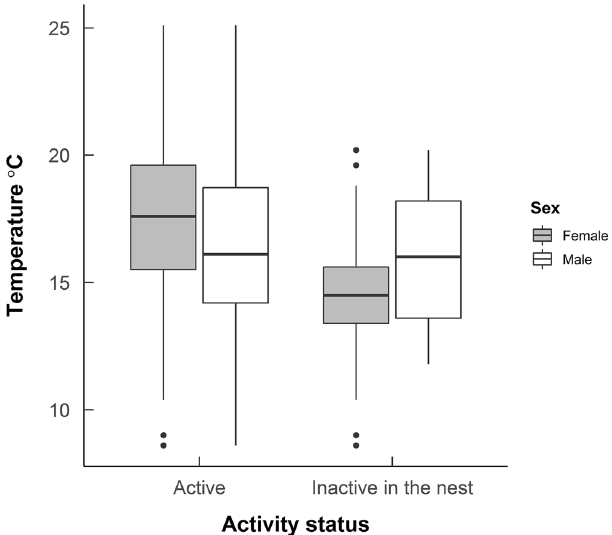
Figure 2. The mean nightly temperature on nights where male and female hedgehogs spent all night inactive and in the nest, compared with the mean nightly temperature when hedgehogs were active. Data includes 20 individuals, radio-tracked in Qatar from November 2010 to February in 2011 and November 2011 to February 2012. Lower and upper hinges show the interquartile range. Whiskers show values within 1.5 times the interquartile range, dots are outliers to